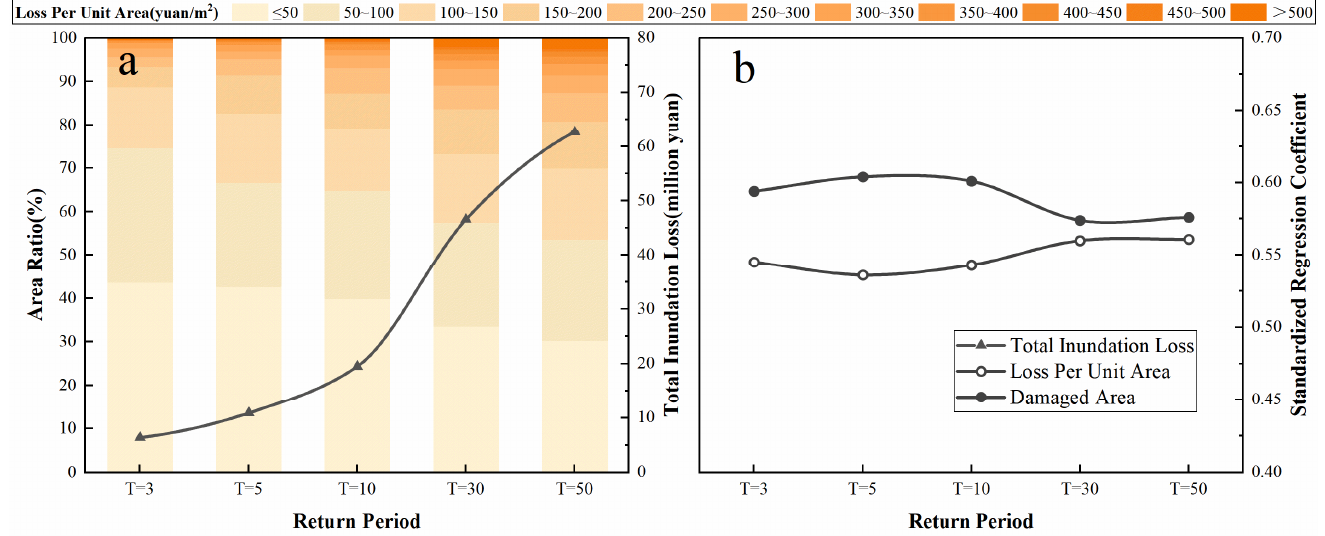
Figure 11. ( a ) Distribution of the ratios of the damaged areas to the total damaged areas in the groups, and the total inundation loss under different return periods; ( b ) standardized regression coefficients under different return periods.